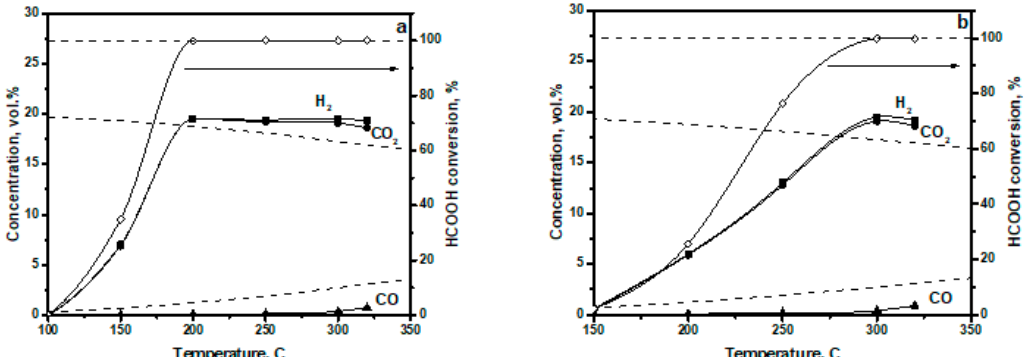
Figure 4. Effect of temperature on formic acid conversion and H 2 , CO and CO 2 outlet concentrations in formic acid decomposition over CuO-CeO 2 / γ -Al 2 O 3 catalyst at gas hour space velocity = 3500 h − 1 ( a ) and gas hour space velocity = 35,000 h − 1 ( b ). Reaction conditions: p = 1 atm, inlet composition, vol.%: N 2 :HCOOH = 75:25. Solid lines—experiment, dotted lines—thermodynamic equilibrium values.